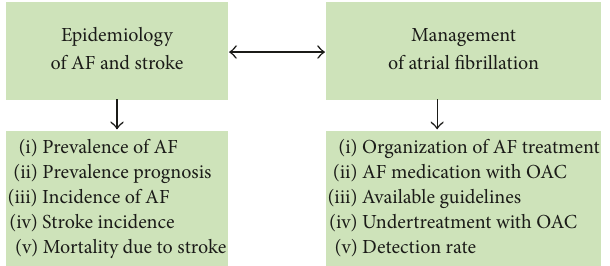
Figure 2: Interconnection dimensions in